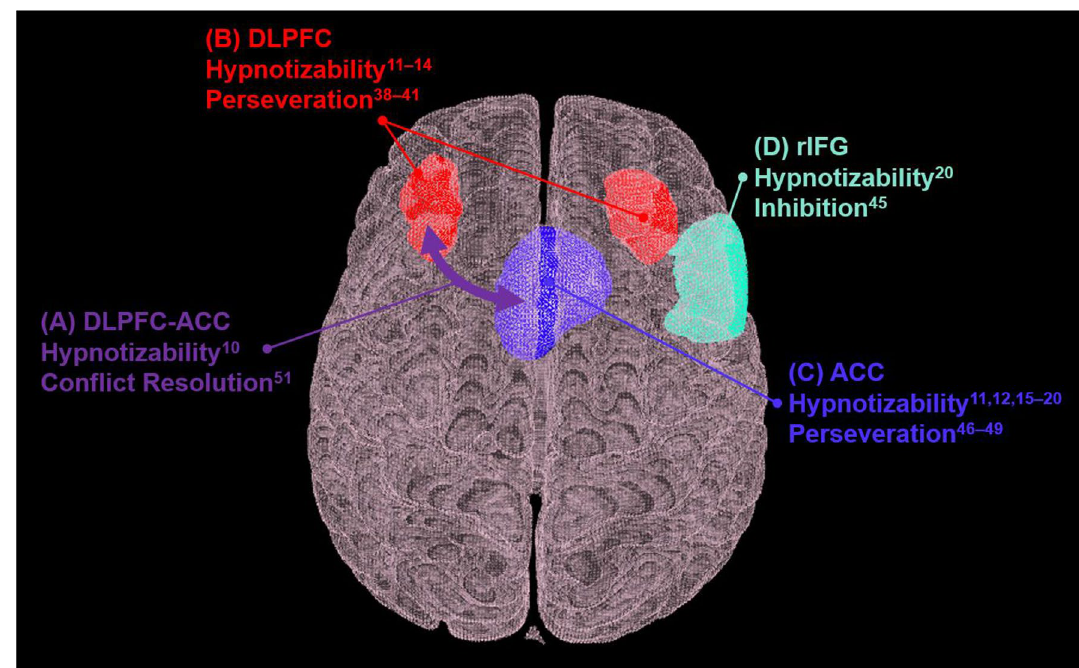
Figure 1. Summary of brain regions of interest. Hypnotizability: ( A ) Hypnotizability is associated with increased functional connectivity between left DLPFC and the dACC 6 ; High hypnotizability is related to altered activity in the ( B ) DLPFC 7–10 and the ( C ) ACC 7,8,11–16 , and is associated with ( D ) greater recruitment of the rIFG during incongruent trials of selective attention tasks 16 . Perseveration: ( A ) The interplay between the DLPFC and ACC plays a central role in the processing of cognitive conflicts 54 ; The ( B ) PFC is related to perseveration in both humans 41–44 and nonhuman primates 45–47 ; The ( C ) ACC is also associated with perseveration in both human 49–52 and animal models 53 ; ( D ) The rIFC (includes the rIFG) is a central component in the inhibition of executive control 48 ; Lower performance on the WCST is linked to impairments in the ( B ) PFC, ( C ) ACC, and ( D ) IFC 63–65 . ACC = anterior cingulate cortex; DLPFC = dorsolateral prefrontal cortex; PFC = prefrontal cortex; rIFC = right inferior frontal cortex; rIFG = right inferior frontal gyrus; WCST = Wisconsin Card Sorting